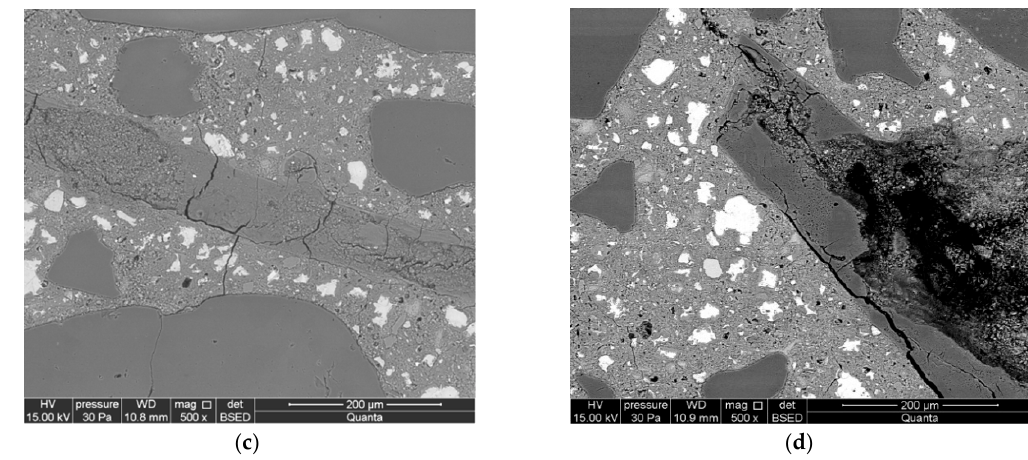
Figure 7. Microstructure of reference mortars, analyzed along with the progress of the reaction after ( a ) 1 day, ( b ) 3 days, ( c ) 7 days, and ( d ) 14 days.